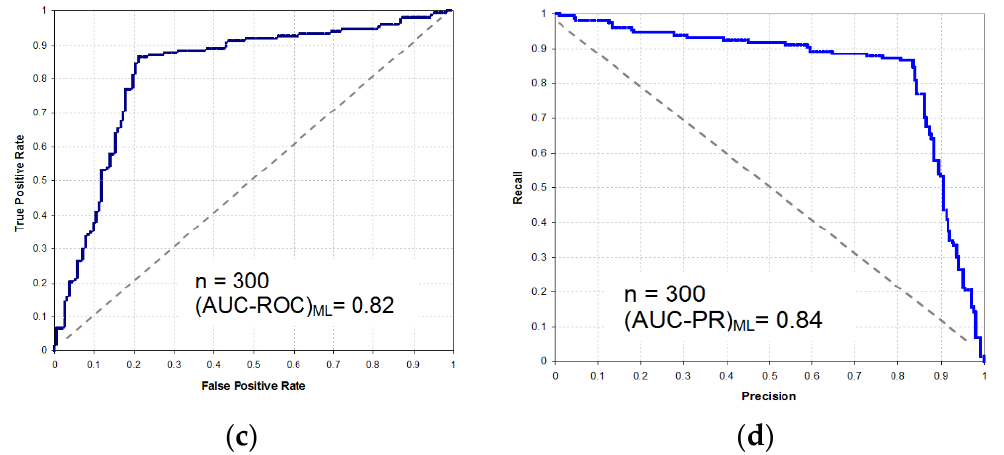
Figure 9. Comparative characteristics of the ML-models in ROC and PR space for different sample sizes: ML-model in AUC-ROC space where n = 200 ( a ), ML-model in AUC-PR space where n = 200 ( b ), ML-model in AUC-ROC space where n = 300 ( c ), and ML-model in AUC-PROC space where n = 300 ( d ).